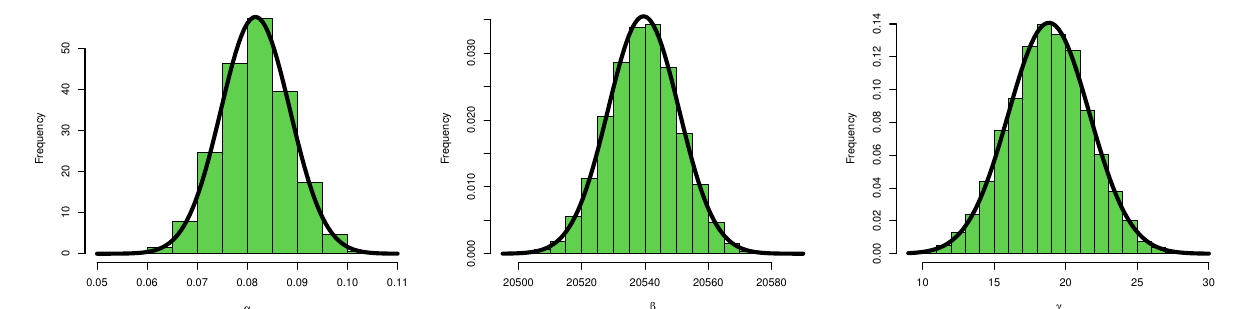
Figure 16. Histogram plot with normal curve for parameters of the KMWE model for food and drink wholesaling